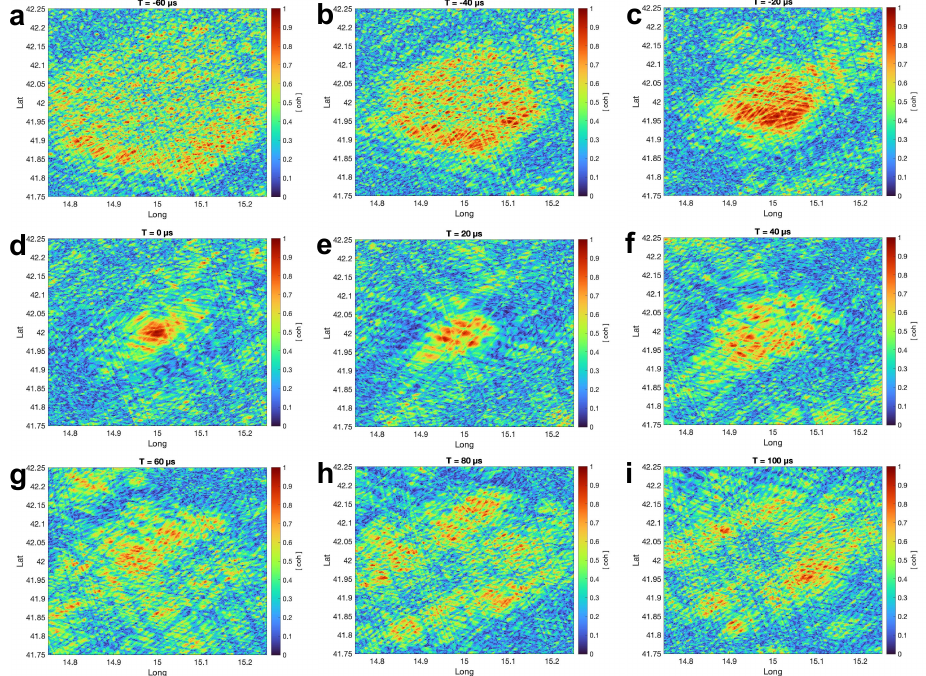
Figure 11. The coherency maps with a small receiver network with a simulated lightning location of 15°E and 42°S ( N = 10). Each sub-figure ( a – i ) is the coherency map at a different time.